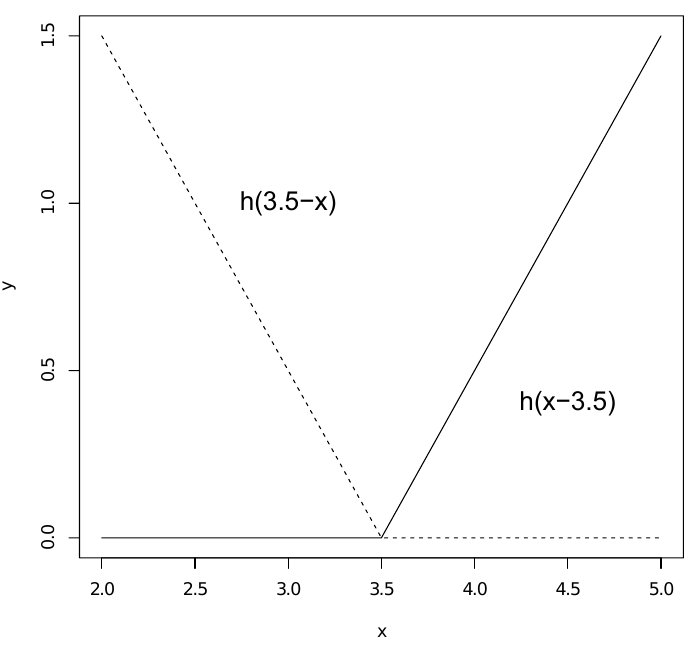
  tx  tx  , ) is   tx  tx  , ) as a solid line.